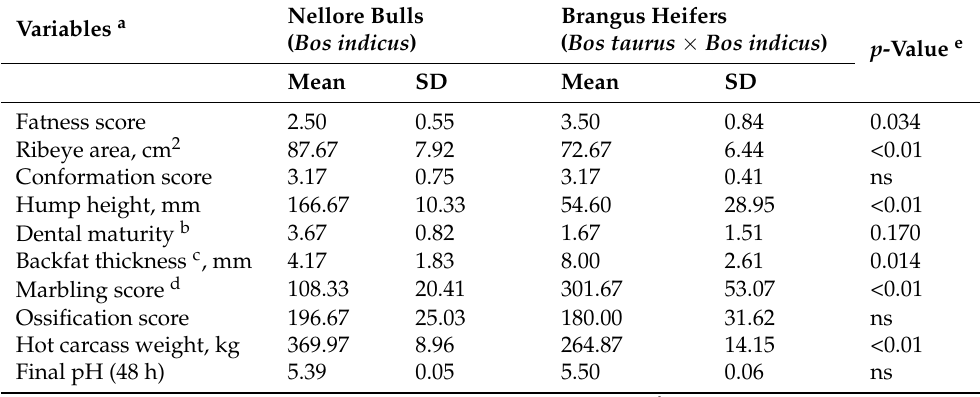
Table 1. Carcass measurements of feedlot-finished Nellore bulls ( n = 10) and Brangus heifers ( n = 10), whose half-carcasses were suspended after slaughter by the traditional Achilles tendon method ( n = 20) or by the pelvic bone ( n =